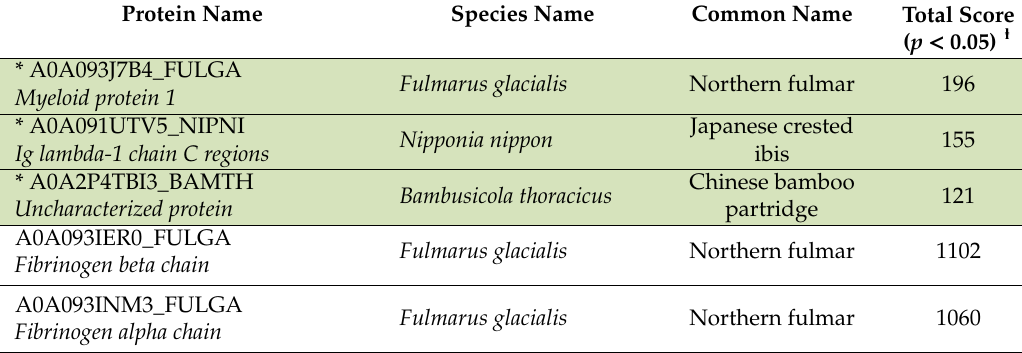
Table 1. Deiminated protein hits identified by F95 enrichment in plasma of northern giant petrel ( Macronectes halli ). Deiminated proteins were isolated by immunoprecipitation using the pan-deimination F95 antibody. The F95-enriched eluate was analysed by LC–MS/MS and peak list files were submitted to mascot. Peptides matching with Aves_class_20190709 (876,224 sequences; 364,491,521 residues) are shown and total score is reported. Protein hits with Aves are indicated, including species name. Protein hits which were identified as deiminated in northern giant petrel only, and not in wandering albatross or south polar skua are listed first and highlighted in light green and with an asterix (*). For full LC–MS/MS data analysis, see Supplementary Table S1.